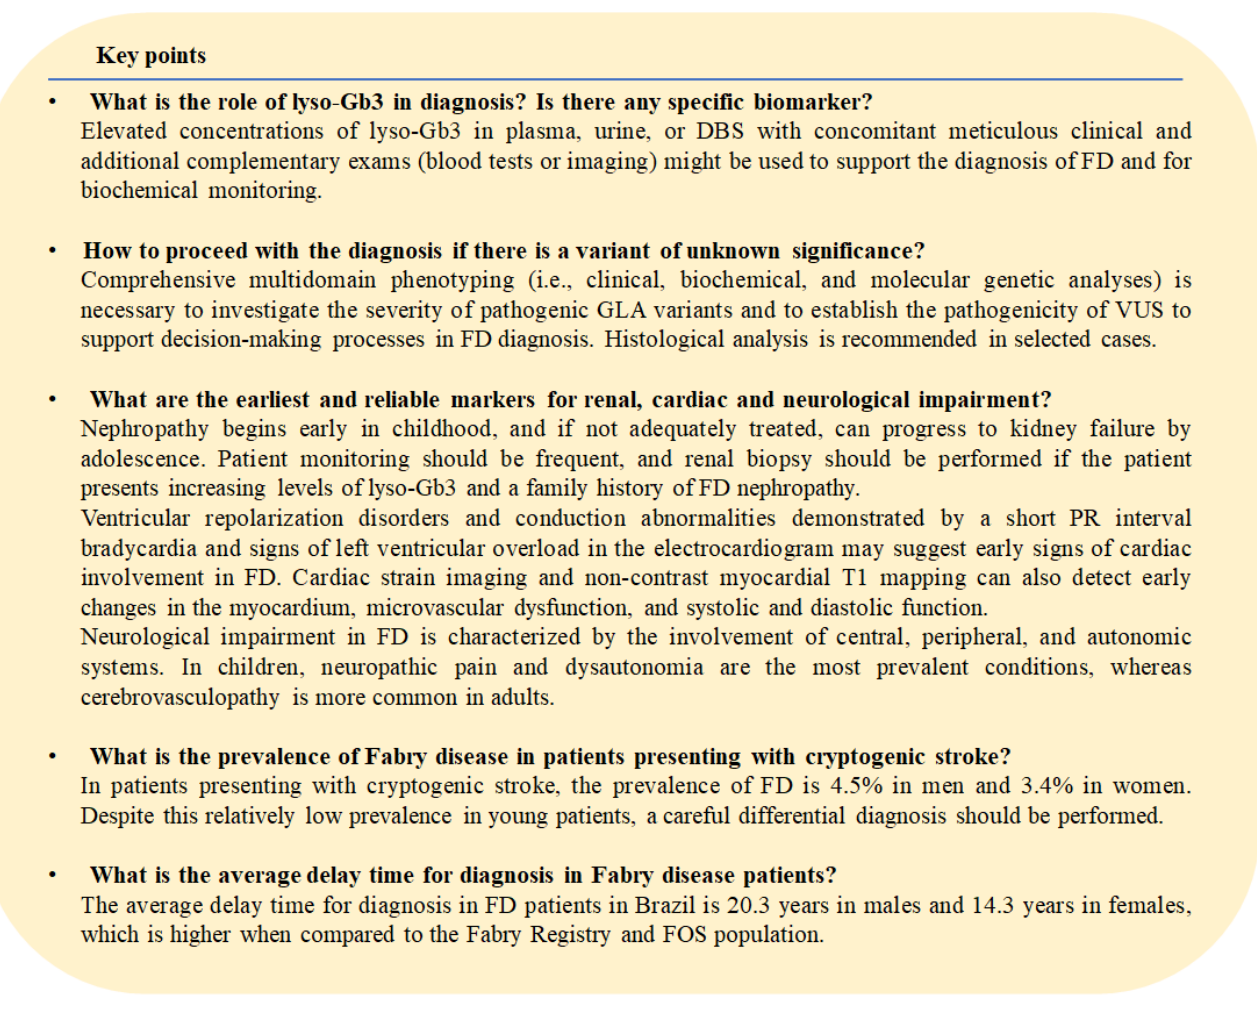
Figure 1. Summary of the findings. FD: Fabry disease; GLA: α-galactosidase A; VUS: variant of unknown significance; ECG: electrocardiogram; FOS: Fabry Outcome